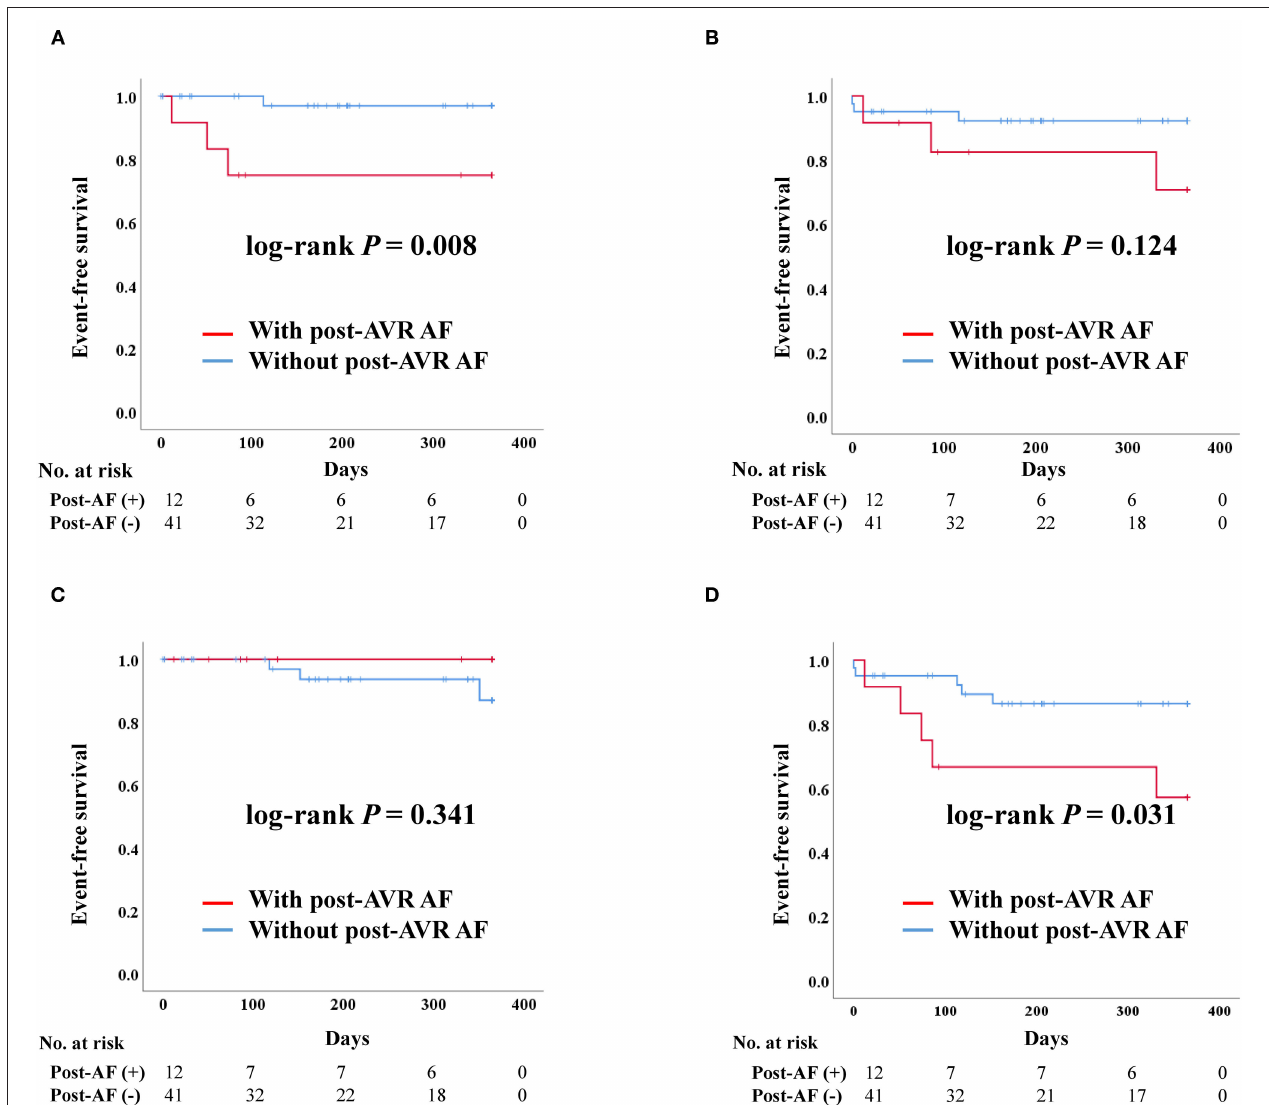
FIGURE 4 | Clinical outcomes of transcatheter aortic valve replacement (TAVR) according to post-TAVR atrial fibrillation after propensity score matching. Post-AVR AF, Post-transcatheter aortic valve replacement atrial fibrillation; Composite outcome, Composition of admission due to heart failure, stroke, or death. (A) Admission due to heart failure. (B) Death. (C) Stroke. (D) Composite